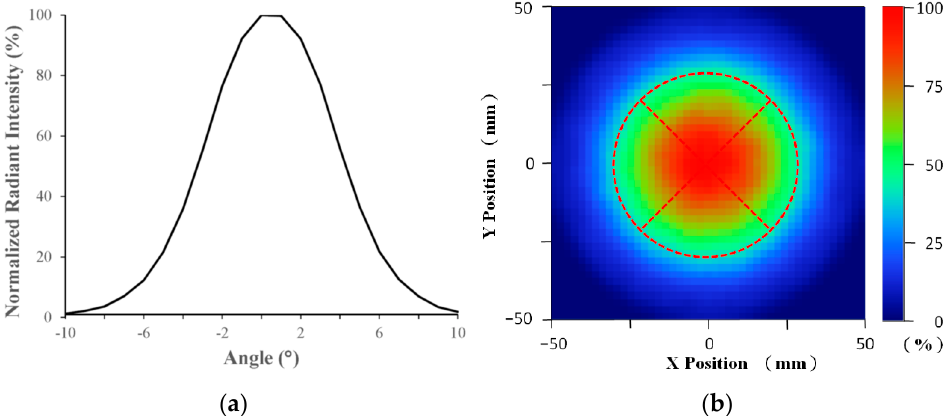
Figure 1. ( a ) Angle distribution and ( b ) irradiance distribution of the designed LPL unit on the exposure working